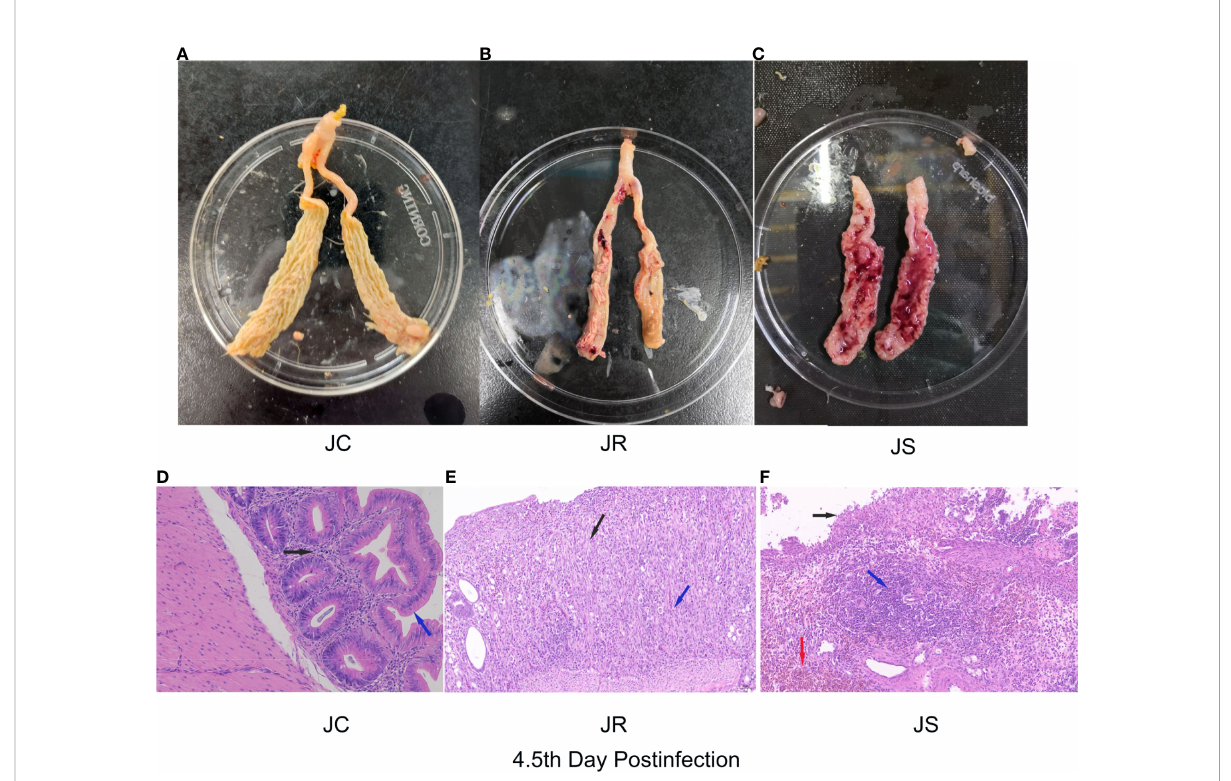
FIGURE 1 Histological and pathological images of cecal tissues of chickens at 4.5 days after E. tenella infection. (A – C) Images of chicken cecal tissues at 4.5 days post-infection in the JC group (A) , JR group (B) , and JS group (C) . (D – F) Pathological analysis of chicken cecal tissues at 4.5 days post-infection in the JC group (D) , JR group (E) , and JS group (F) .